Question: In one sentence, what is this figure communicating?
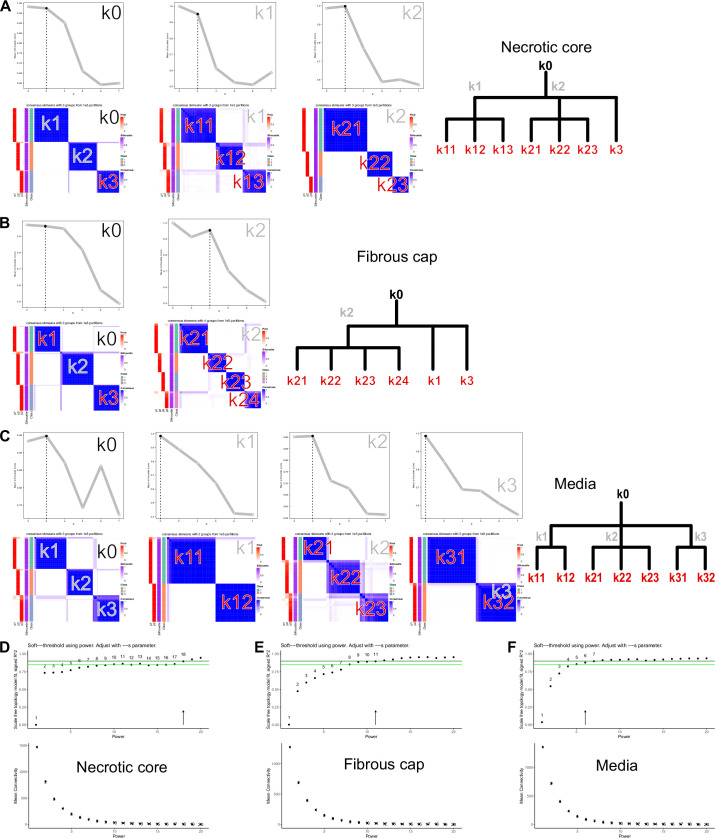
Answer: Plaque subregion proteomes show distinct abundance structure and necrotic core subtypes. a , Numbers of quantified proteins per sample across plaque subregions after quality control. Proteins with >66% missing values and samples with <1,500 quantified proteins were excluded. Sample sizes are indicated below each subregion. Points indicate individual plaque samples, boxes indicate the median and interquartile range, and whiskers show the data range, except for outlier points, which were determined using the interquartile range. Significance ( P < 0.0001) was determined using a t -test. Fcap, fibrous cap; Ncore, necrotic core. b , Protein detection and abundance characteristics across plaque subregions. The scatterplot shows median protein intensity (log 2 ) versus observation count, with points colored by abundance decile; selected proteins are annotated. The accompanying heat map summarizes the distribution of functional protein classes across abundance deciles. c , Consensus clustering of necrotic core proteomes ( n = 110) using the top 66% most variable proteins identified seven subclusters ( K = 7; Extended Data Fig. 2 ). The heat map shows z -scored protein abundances (red, higher; blue, lower), organized by weighted correlation network analysis-derived protein modules (MG0–MG6; top annotation). MG0 denotes low-membership or unassigned proteins. Bottom annotations indicate module membership strength and statistical significance. Clinical covariates and plaque characteristics are shown as row annotations (right). PAD, peripheral artery disease; PFI, platelet function inhibition. Source data